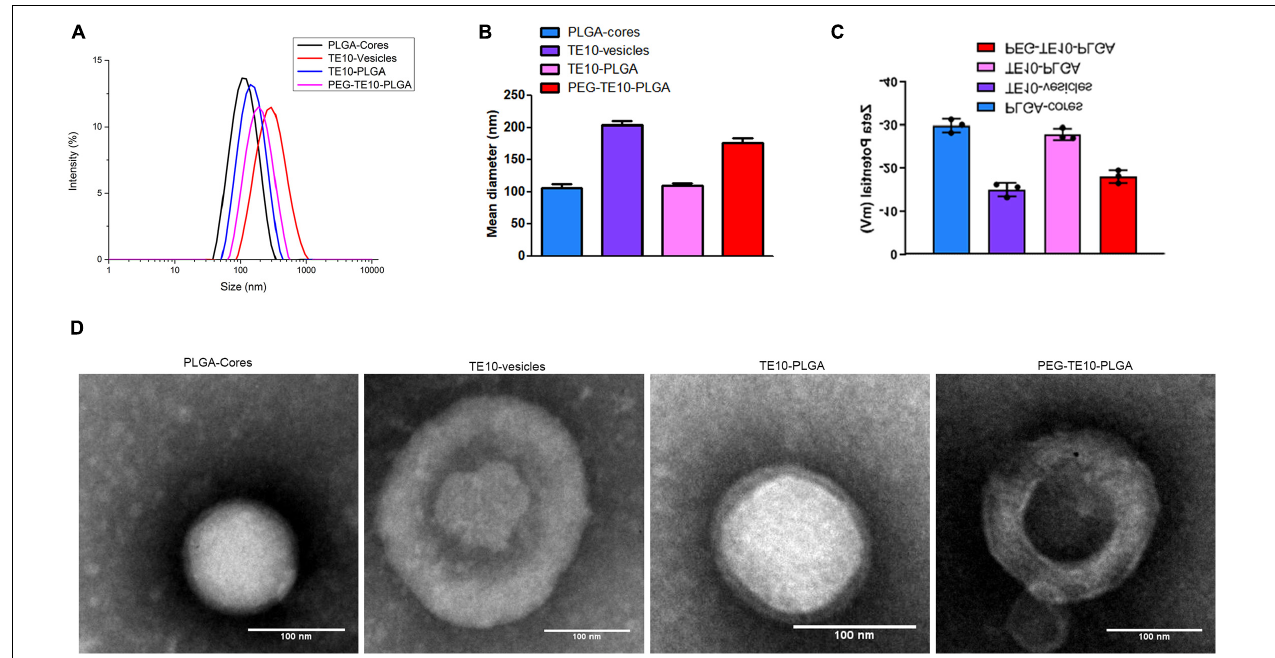
FIGURE 1 | Characterization of PMPNs. Malvern laser particle size analyzer was used to analyze the particle size distribution (A) , the average diameter (B) , and the Zeta potential (C) of PLGA-Cores, TE10-vesicles, TE10-PLGA and PEG-TE10-PLGA. (D) TEM imaging of the four PMPNs. Scale bar = 100